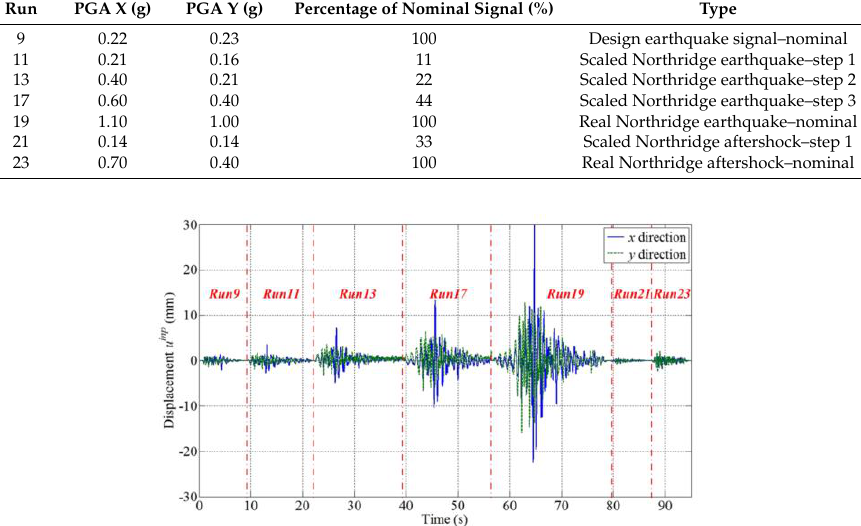
Figure 22. High-intensity ground motions for a nonlinear seismic analysis of the SMART 2013 structure.